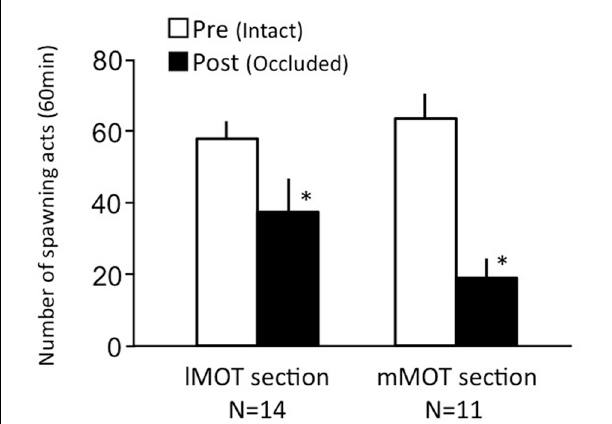
FIGURE 7 | Effects of section of medial olfactory tract components on female sexual behavior in female goldfish. lMOT section, lateral medial-olfactory tract section. mMOT section, medial medial-olfactory tract section. Pre-treatment (open column). Post, post-treatment (solid column, bilaterally occluded and either lMOT sectioned or mMOT sectioned). Each column represents the mean and s.e.m. Difference compared to pre-treatment (asterisk). Level of significance, p < 0 .